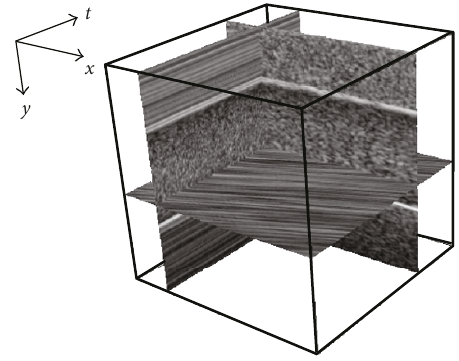
Figure 7: 3D view of the spatiotemporal volume from an experi- mental US image